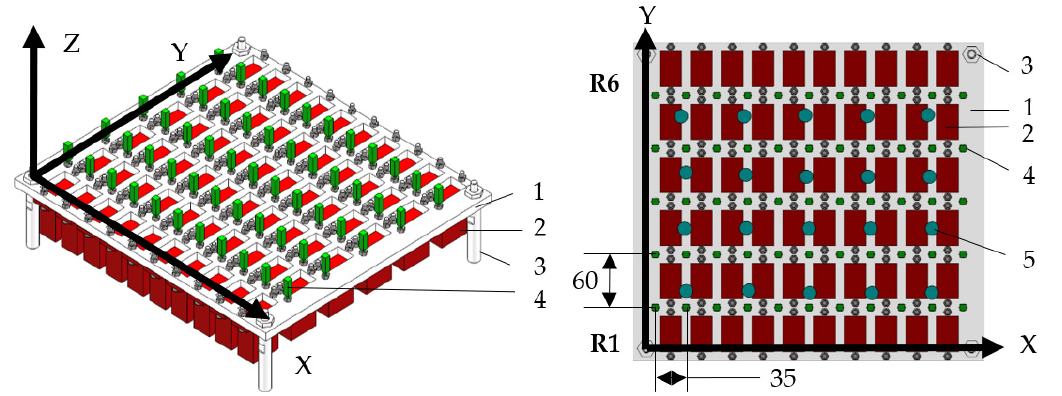
Figure 1. Schematic diagram of the simulation panel. 1. panel; 2. heater ( 10 × 6 ); 3. column ( 2 × 2 ); 4. cuboid measuring standard part ( 11 × 5 ); 5. temperature sensor (number: 20).